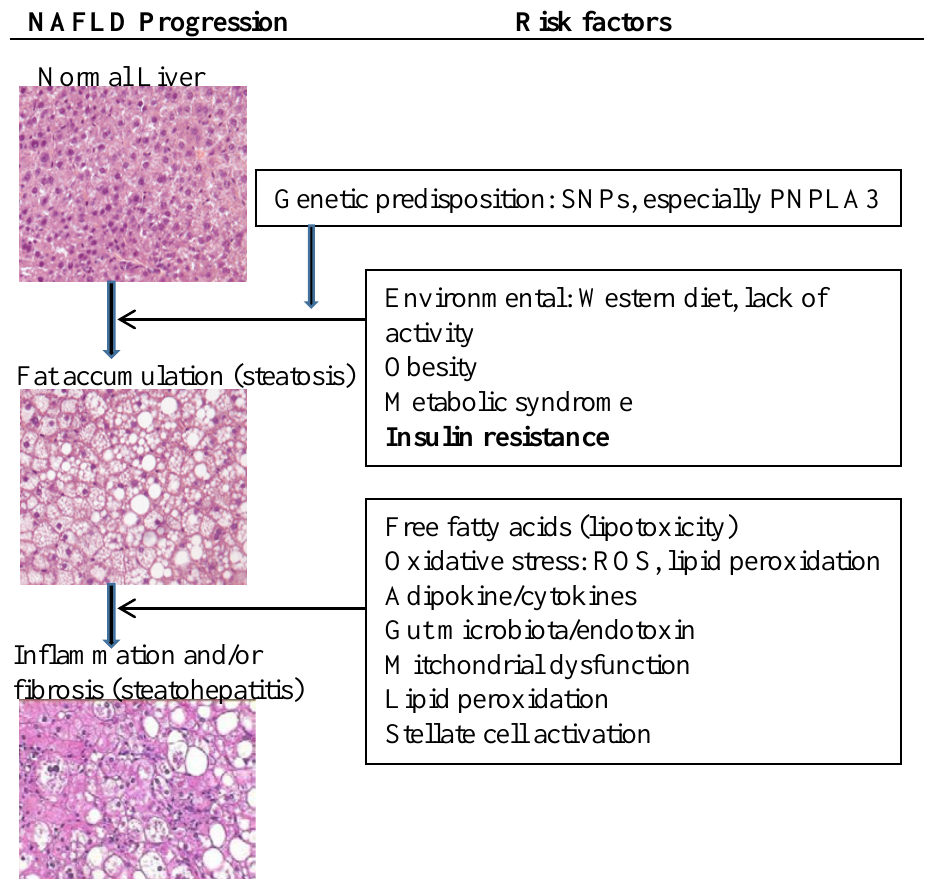
Figure 1. Current understanding of non-alcoholic fatty liver disease (NAFLD) pathogenesis. In individuals with genetic predisposition, insulin resistance plays a crucial role in